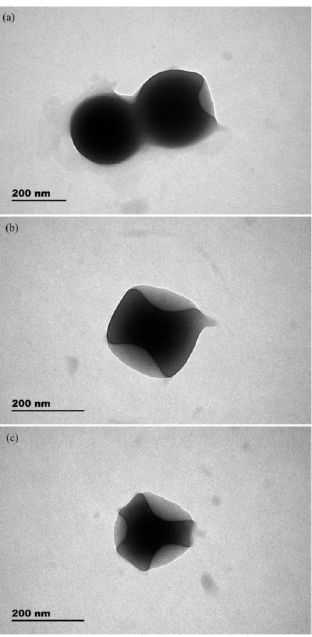
Figure 5. Transmission electron microscopy (TEM) images of nano-titania functionalized COFs, i.e., SSTF-COFs ( a ), DSTF- COFs ( b ) and CSTF-COFs ( c ), at different solvothermal reaction stages of 24, 48 and 72 h, respectively. Reprinted from [60] with permission of Elsevier.